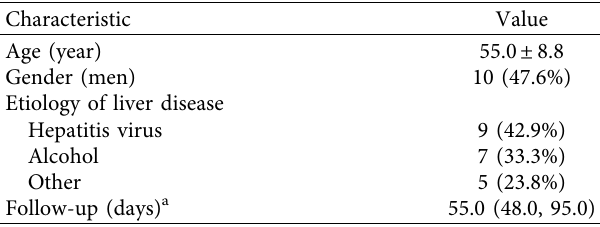
Table 1: Participant characteristics ( n �